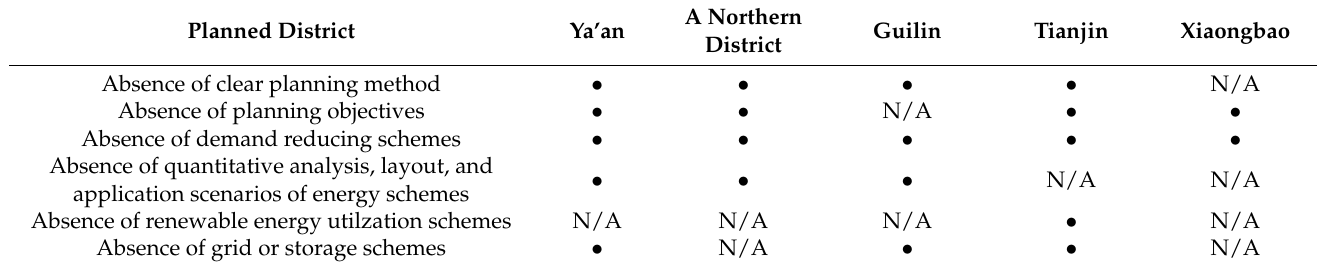
Table 1. The limitations of recent research into district energy